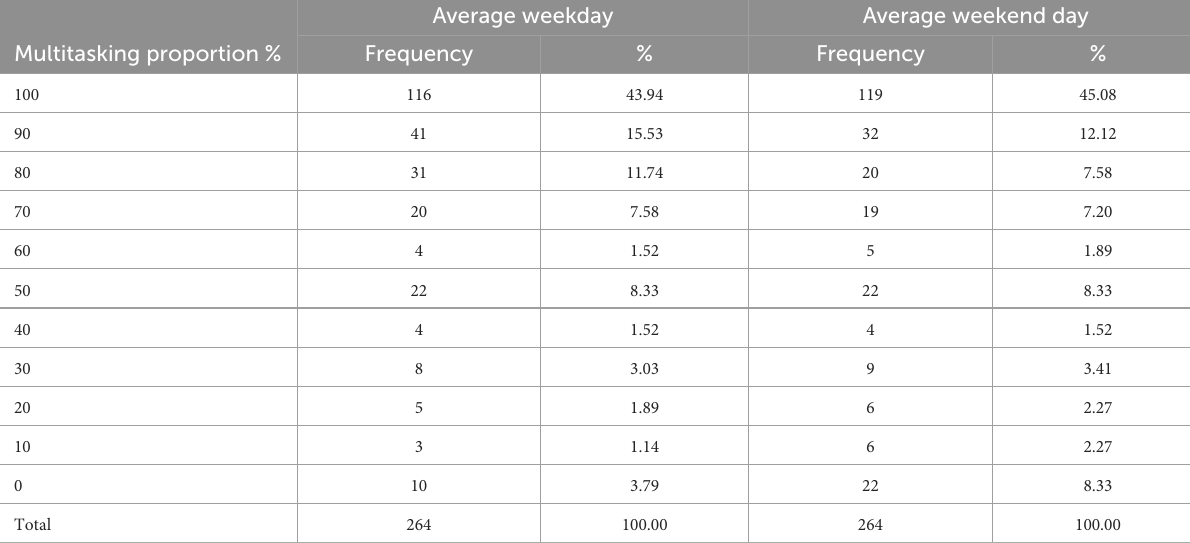
TABLE 7 Proportion of time participants spend multitasking while listening to podcasts using a smartphone on average weekdays and weekend days ( N =